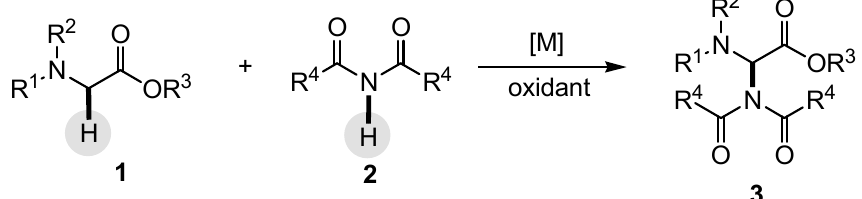
Figure 1. Unnatural amino acids synthesis by cross-dehydrogenative Figure 33. Unnatural amino acids synthesis by cross-dehydrogenative coupling.